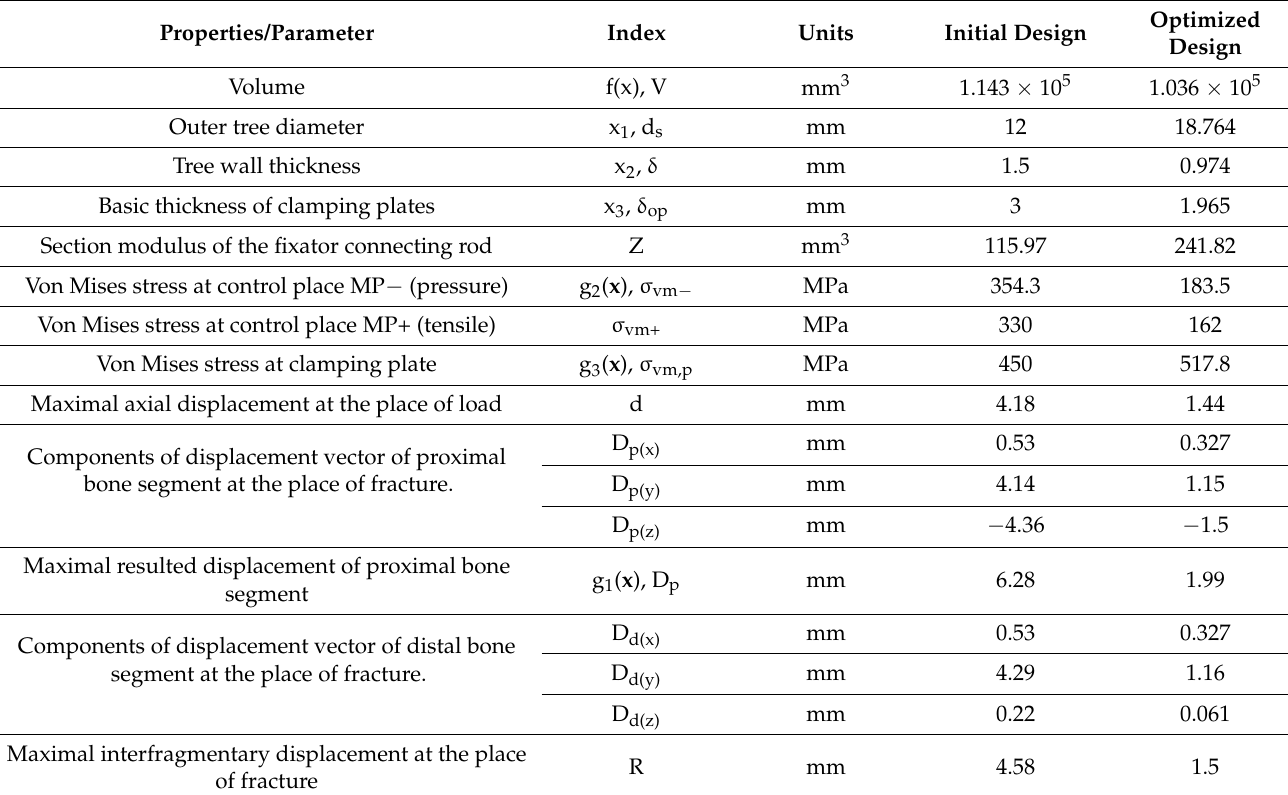
Figure 17. Difference between calculated and allowed von Mises stresses ( σ vm − ) at fixator tree during the optimization process.